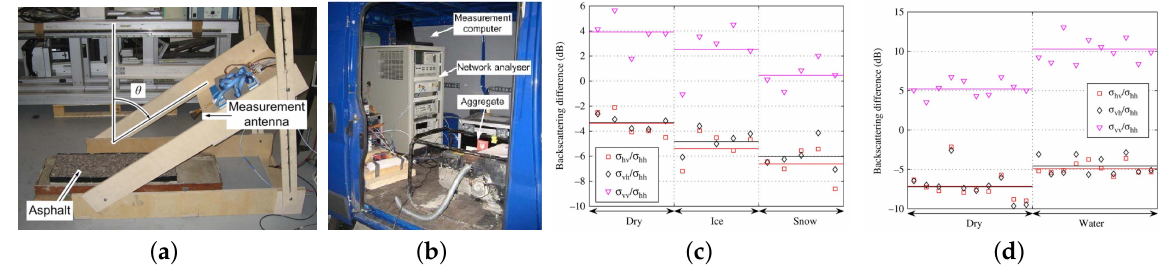
Figure 15. ( a ) Detection device. Horn antenna mounted on the rotating arm points to the asphalt placed on the floor and is used for detection. ( b ) Placement of the detection device on the truck. ( c ) Markers indicate individual measurements, and solid lines indicate the average of the correspond- ing RSC and polarisation values showing the backscatter ratios for different polarisations; the graphs show the backscatter versus polarisation normalisation in different polarisations for dry, ice, and snow asphalt road. ( d ) Backscatter versus polarisation normalised backscatter for dry and wet asphalt at different polarisations